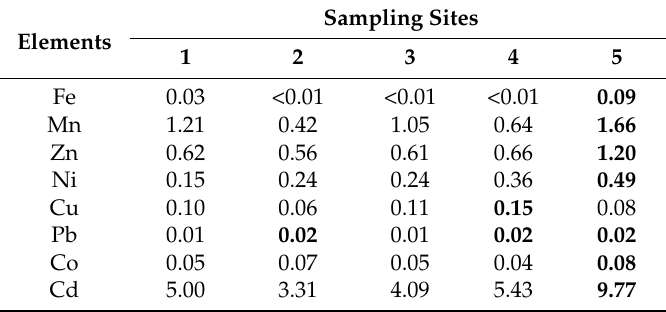
Table 4. Relative mobility (%) of eight metals at five sites in Lake Taihu a .